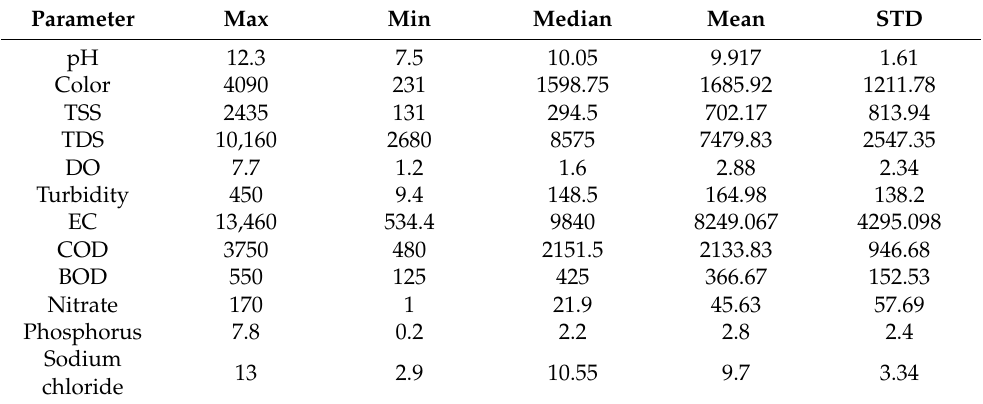
Table 6. The general characterization of the raw wastewater characteristics (number of samples =